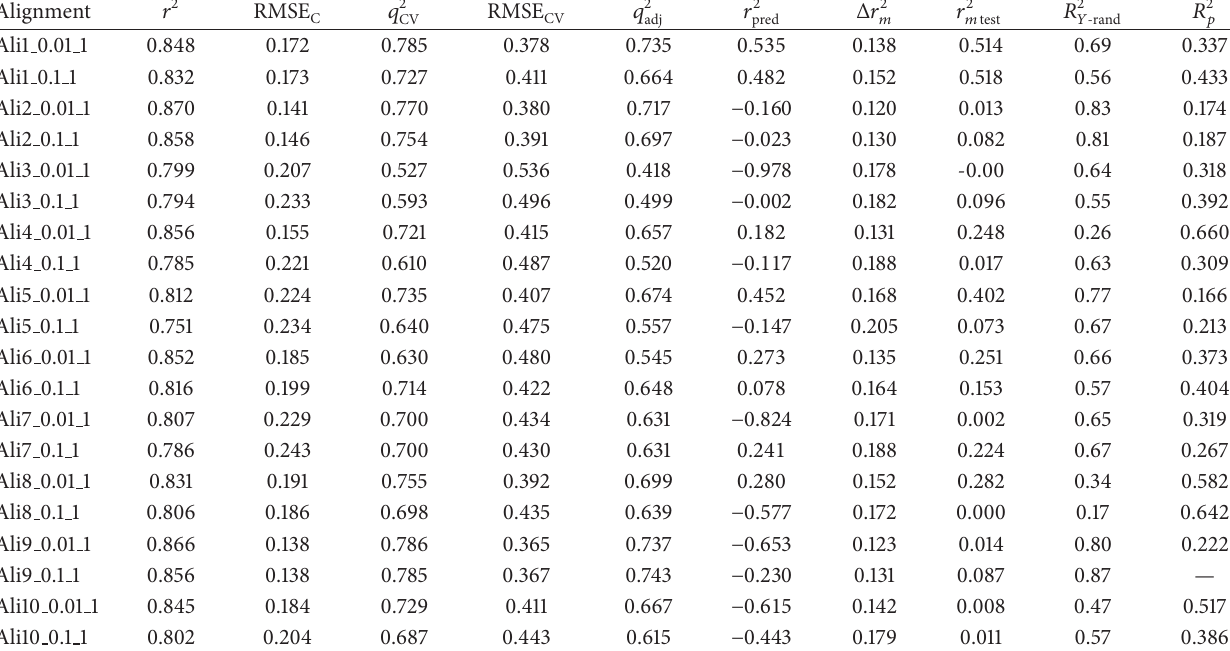
Table 1: Summary of the results of the best 4D-QSAR models obtained for the ten alignments with Test Group I and their respective cuts. Alignment